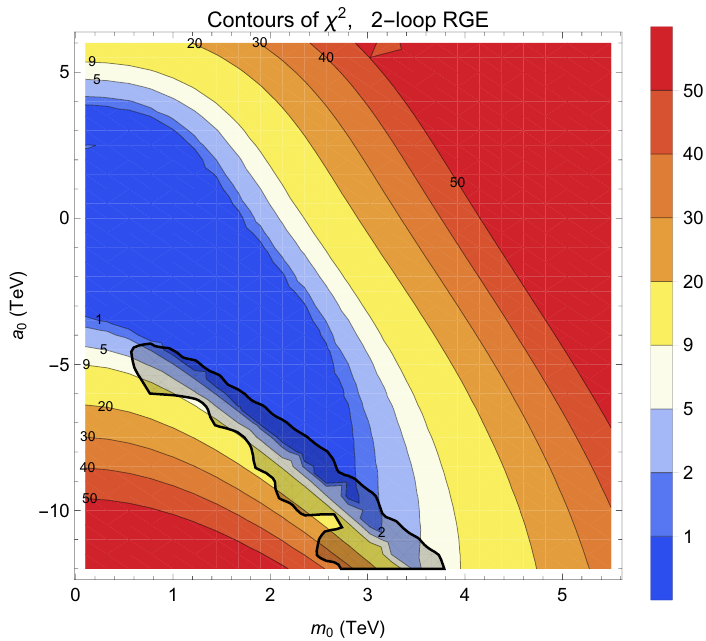
Figure 9 . A contour plot of the minimum (cid:31) 2 for a point with (cid:12)xed m 0 and a 0 , while tan (cid:12) , y 0 and M are varied. The darker region inside the black curve represents minimized points with an 1 = 2 EW vacuum lifetime smaller than 10 (cid:2) the age of the universe. In the lighter region outside of the black curve the vacuum is stable or su(cid:14)ciently